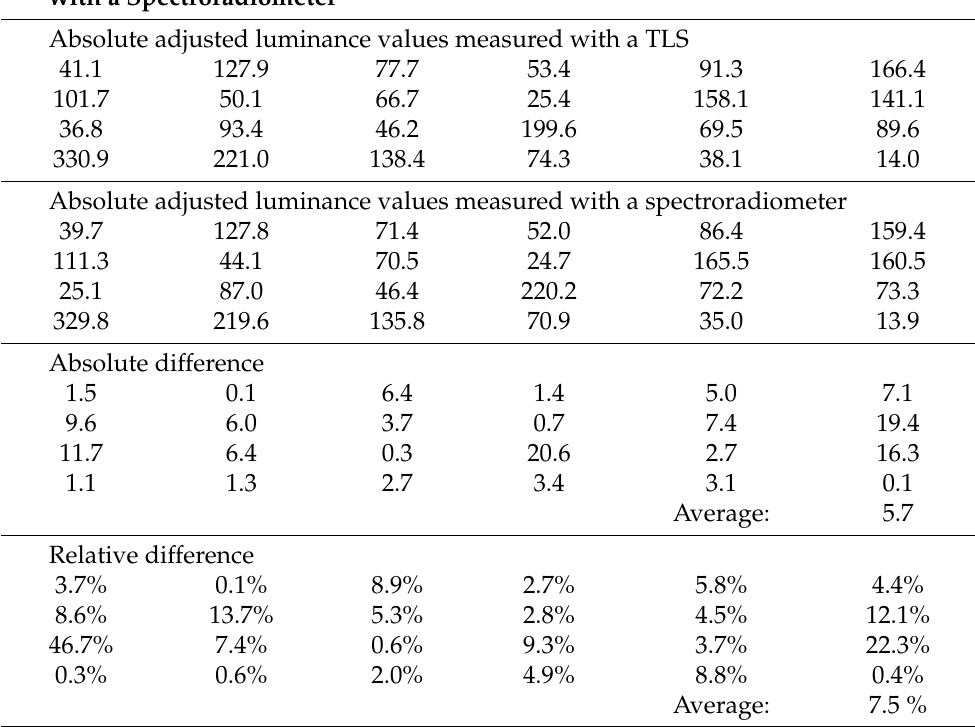
Table 8. The adjusted TLS luminance measurements compared to the reference values measured with a spectroradiometer. The table presents the values ordered according to the reference color target (Figure